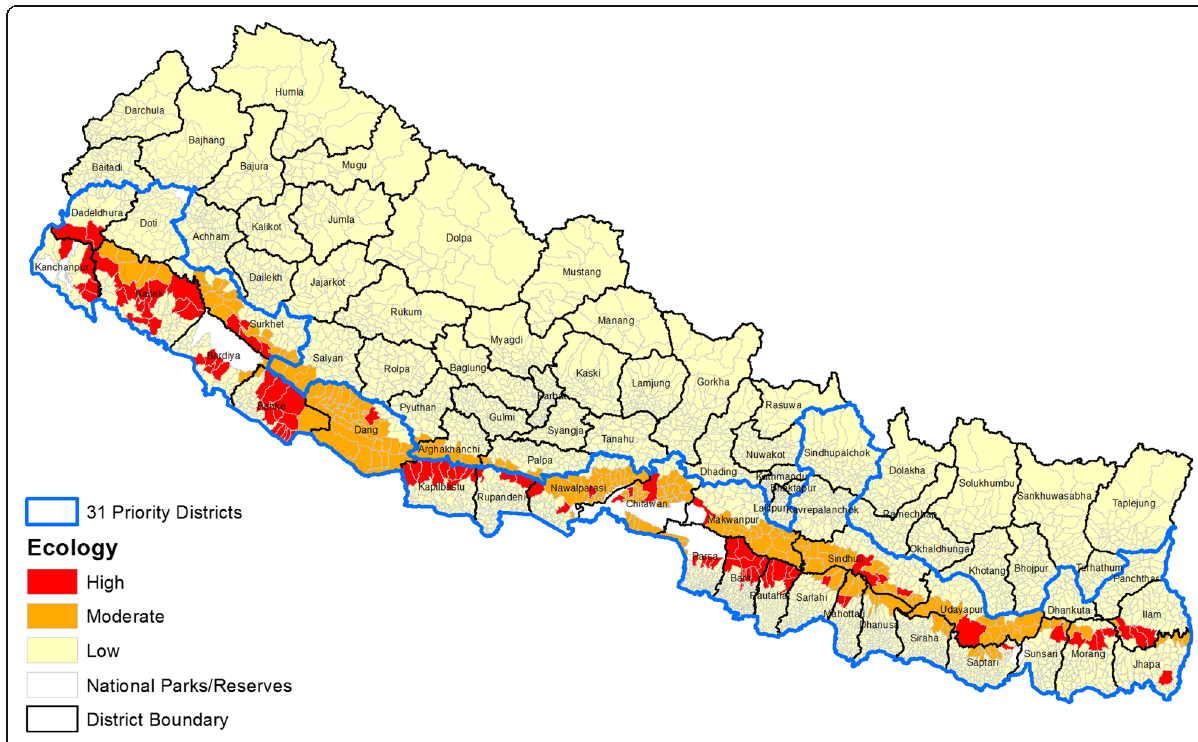
Fig. 5 Entomological risk of malaria transmission